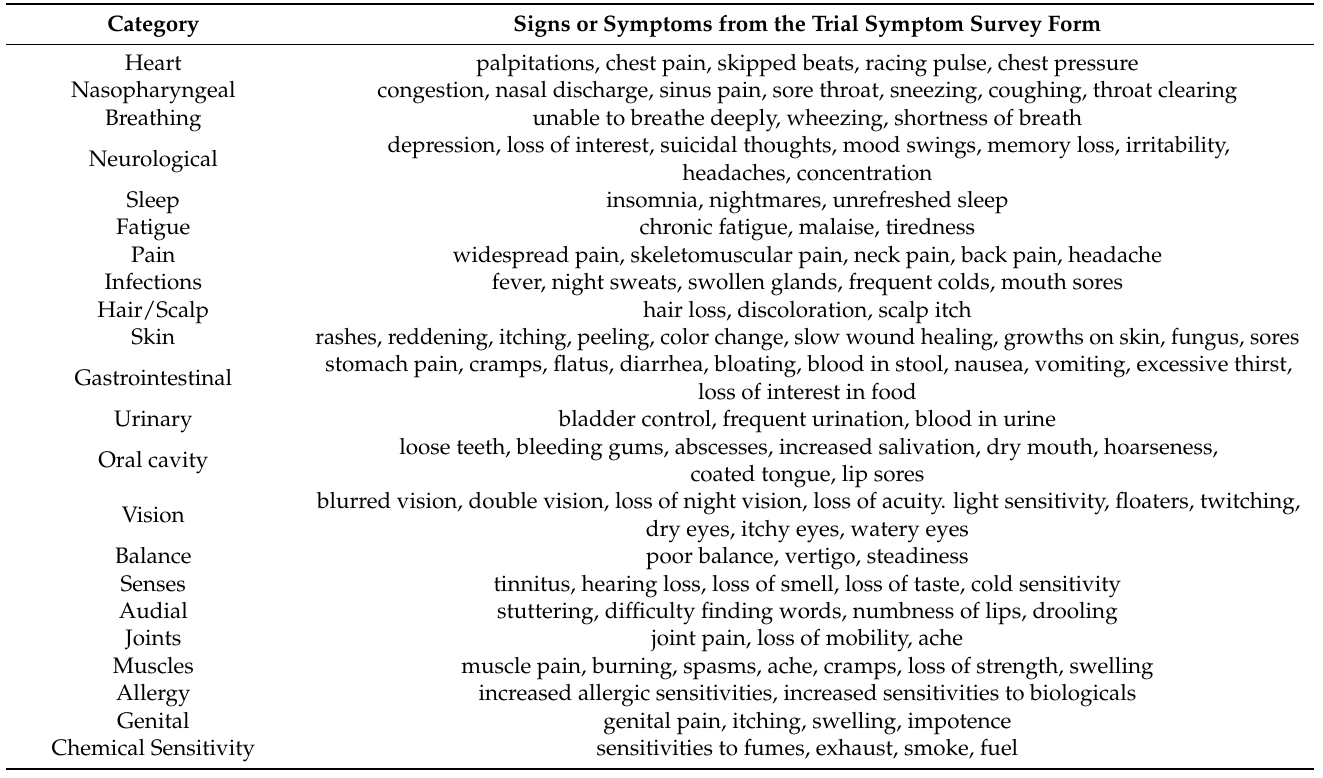
Table 1. Symptom categories based on the Signs and Symptoms Survey